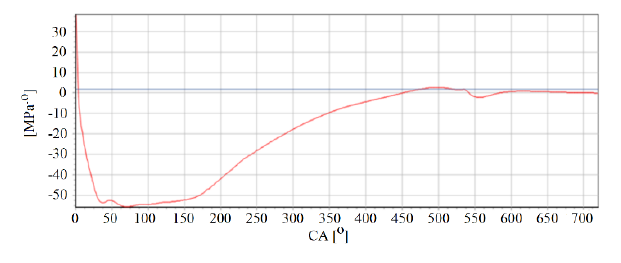
Fig. 4. Course of K measure Table 3. Summary of the results obtained as a result of model, and empiri- cal tests for an engine operating at a rotational speed of 750 rpm and a load of 5.12 kNm